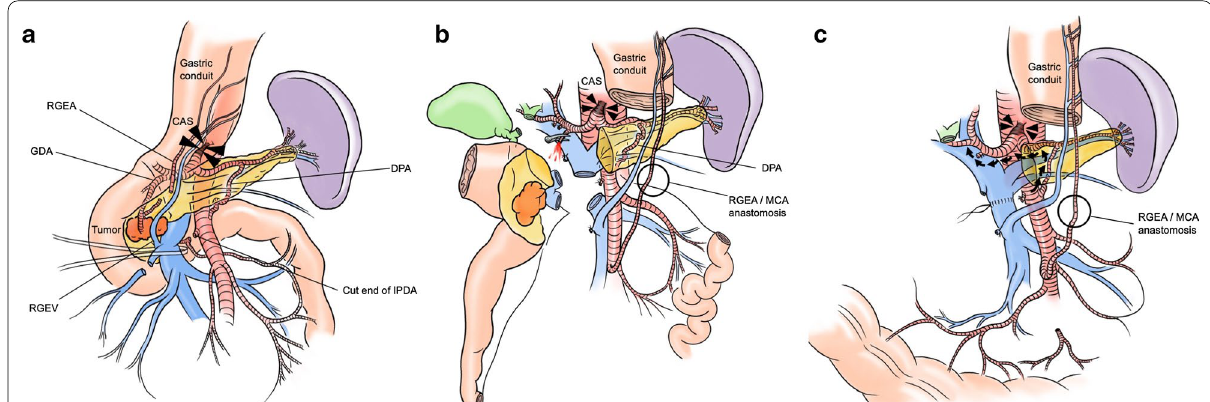
Fig. 3 Graphic illustration of the operation record. a Right gastroepiploic artery (RGEA) was dissected along with the tumor, and there was no backflow from the cut end of the gastric conduit side. At the lower edge of the pancreatic body, the dorsal pancreatic artery (DPA), which communicated with the splenic artery (SPA), was identified. b When the gastroduodenal artery (GDA) was dissected, good blood flow from the cut end of the side of hepatic arteries was established. c Arterial blood flow in the proper hepatic artery (PHA) was provided from the superior mesenteric artery (SMA) to the SPA via the DPA (black arrow head)